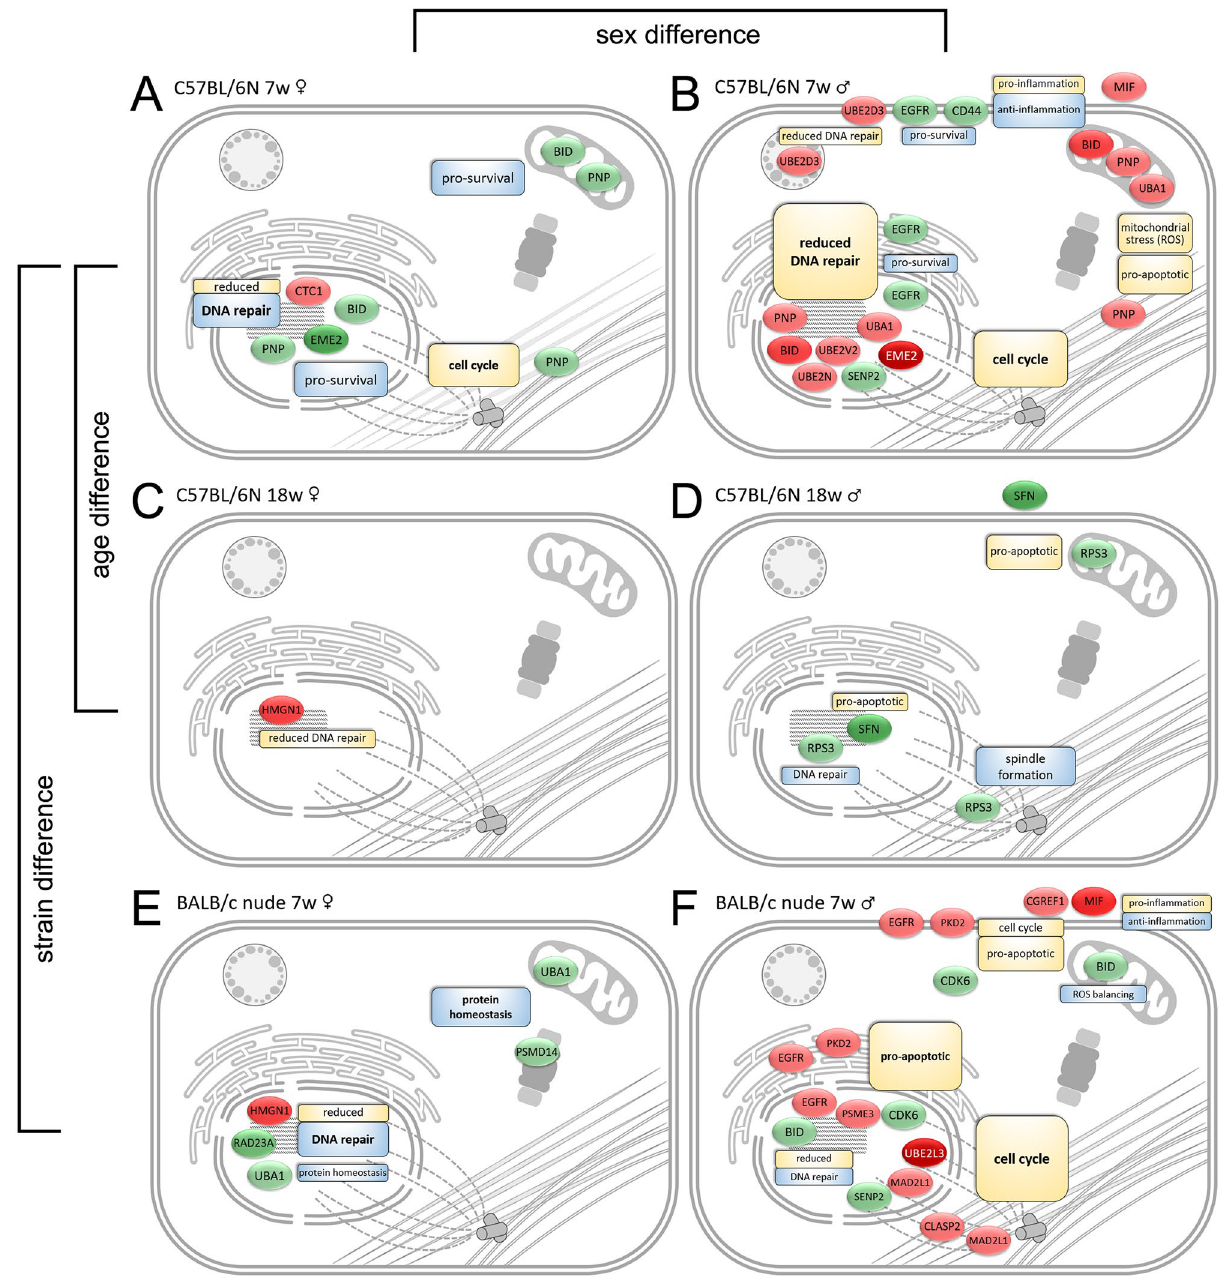
Figure 7. Cellular localization and outcome of differentially abundant proteins associated with DNA damage and repair pathways. Proteins with differential abundance (|FC|≥ 3) in blood plasma 24 h after 0.5 Gy total body irradiation were enriched with Gene Ontology terms for DNA damage and repair processes. Cellular localization according to UniProt (please note different cellular localizations for certain proteins.) Functional outcome inferred from Gene Ontology terms and protein function according to UniProt. (See SI Appendix, Table S8 for further details on functions, interactions, and references.) Panels ( A – F ) illustrate protein functions and outcomes for each investigated group (see respective header). Green oval, protein is overabundant; red oval, protein is underabundant; note fold change is visualized by color intensity. Blue rectangles, activation of cellular function/outcome; yellow rectangle, inhibition of cellular function/outcome. 7w, 7-weeks-old (juveniles); 18w, 18-weeks-old (adults); ♀ , female; ♂ , male. Please note that presented data is normalized to respective unirradiated control groups. Drawings were produced with Microsoft PowerPoint v16.0.4266.1001 and Adobe Photoshop CS5 Portable